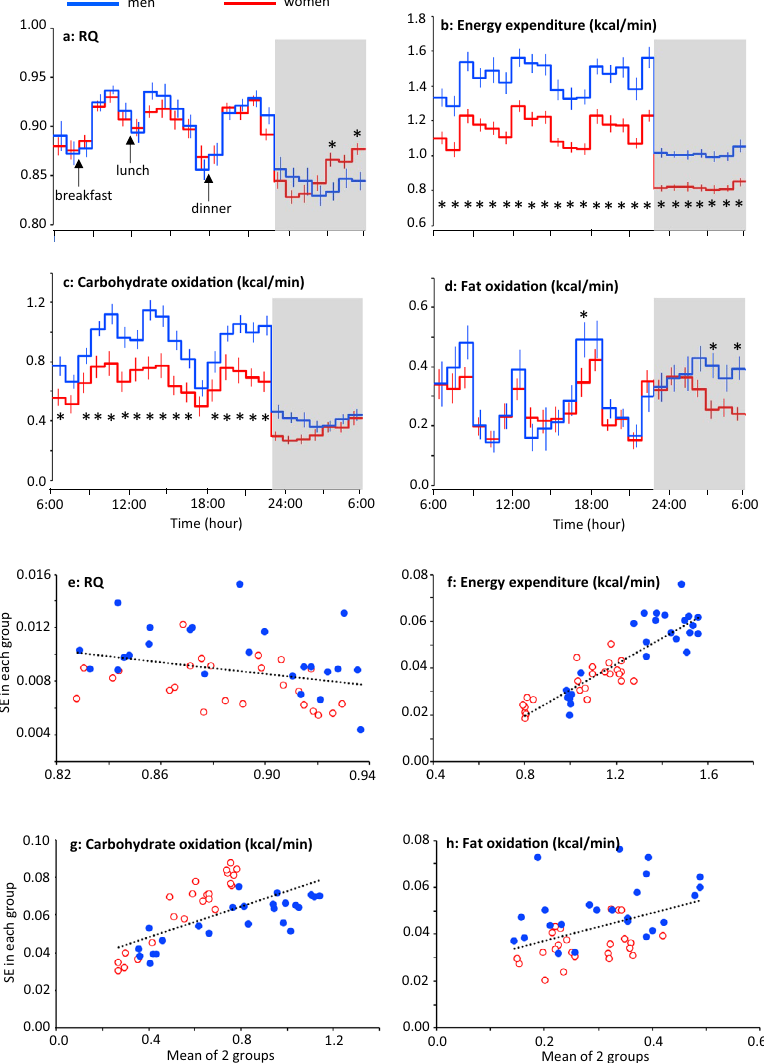
Figure 4. 24-h energy metabolism in men and women. ( a – d ) Mean ± SE of RQ ( a ), energy expenditure ( b ), carbohydrate oxidation ( c ) and fat oxidation ( d ) in 10 men (blue lines) 19 and 9 women (red lines) 18 were calculated from a sedentary trial in previous experiments focused on the effect of exercise on 24-h fat oxidation. Prescribed diet was provided as breakfast (8:00), lunch (12:00), and dinner (18:00). Subjects slept for 7 h from 23:00 to 6:00 (grey bars). A linear mixed-models ANOVA showed a significant effect of time (P < 0.01), and a group × time interaction (P < 0.01) for RQ, energy expenditure, carbohydrate oxidation and fat oxidation. Main effect of group was significant for energy expenditure and carbohydrate oxidation (P < 0.01), but that for RQ (P = 0.924) and fat oxidation (P = 0.461) was not significant. *Represents significant difference between the 2 subgroups by post hoc pair-wise comparisons (P < 0.05). ( e – h ) Relation between the mean and SE of RQ ( e ), energy expenditure ( f ), carbohydrate oxidation ( g ) and fat oxidation ( h ) of men (blue filled circles) and women (red open circles). Negative correlation in RQ and positive correlation in energy expenditure, carbohydrate oxidation and fat oxidation were observed between the mean and